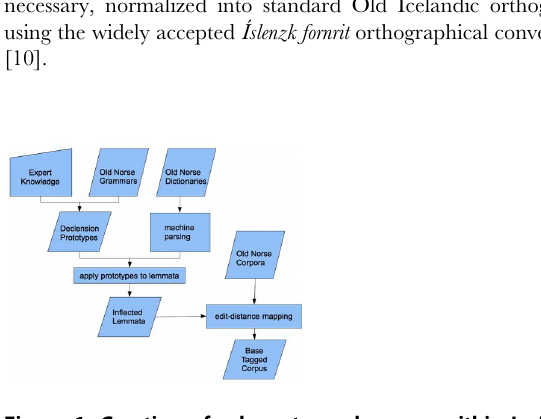
Figure 1. Creation of a base tagged corpus within IceMorph using various data sources. Dictionaries and corpora are machine parsed and inserted into a relational database. Declension prototypes are created by an expert via a functional programming language using Figure 2. Integration of expert feedback to continuously improve POS and morphosyntactic tagging. Human